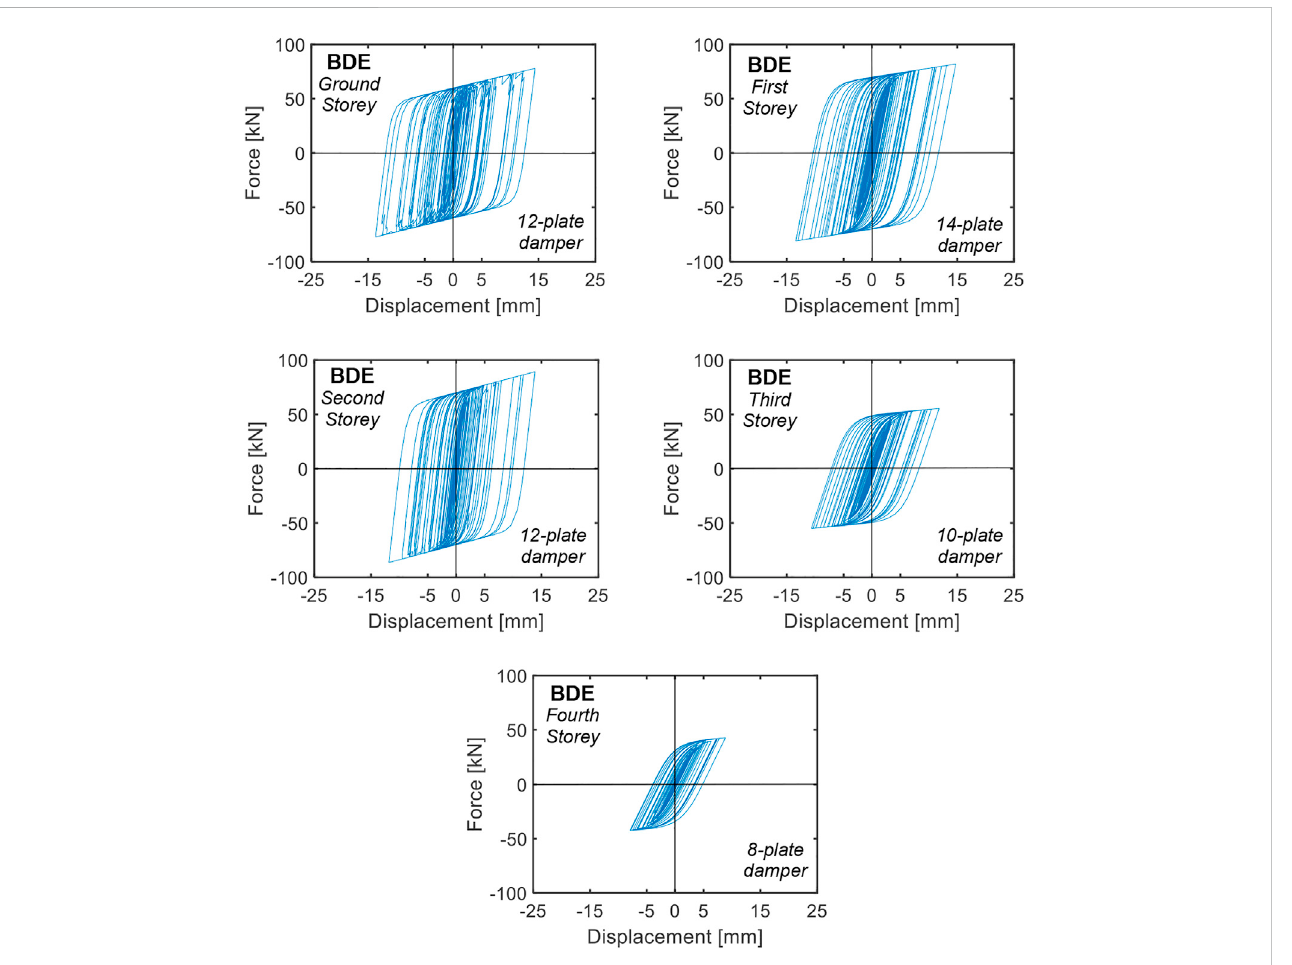
FIGURE 12 Response cycles of the dampers installed in the 1/C-1/D alignment obtained from the most demanding BDE-scaled group of input accelerograms.